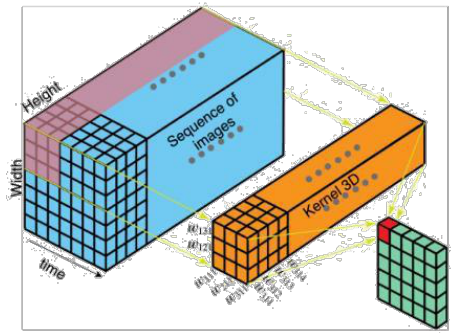
Figure 2. Model accuracy (a) - Model Loss (b)